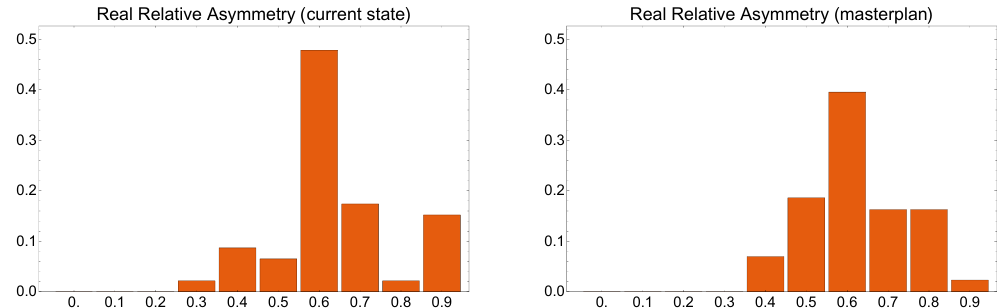
Figure 10. The distribution of Real Relative Asymmetry of the central archaeological area, as in the current situation ( left ) and in the project ( right ).